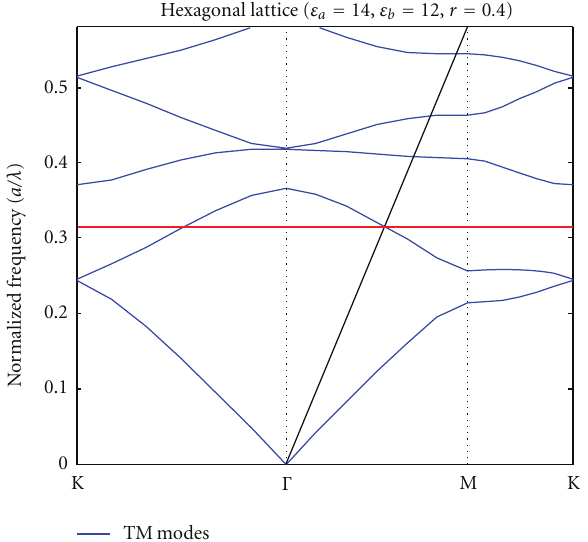
Figure 5: Band curves of 2D PhC of hexagonal lattice for TM polarization. The lattices are made of air holes of radius r = 0 . 4 a in a silicon host material with ε = 12. The light line shifted to Γ point is shown in black. The red line indicates the frequency range of negative refraction.